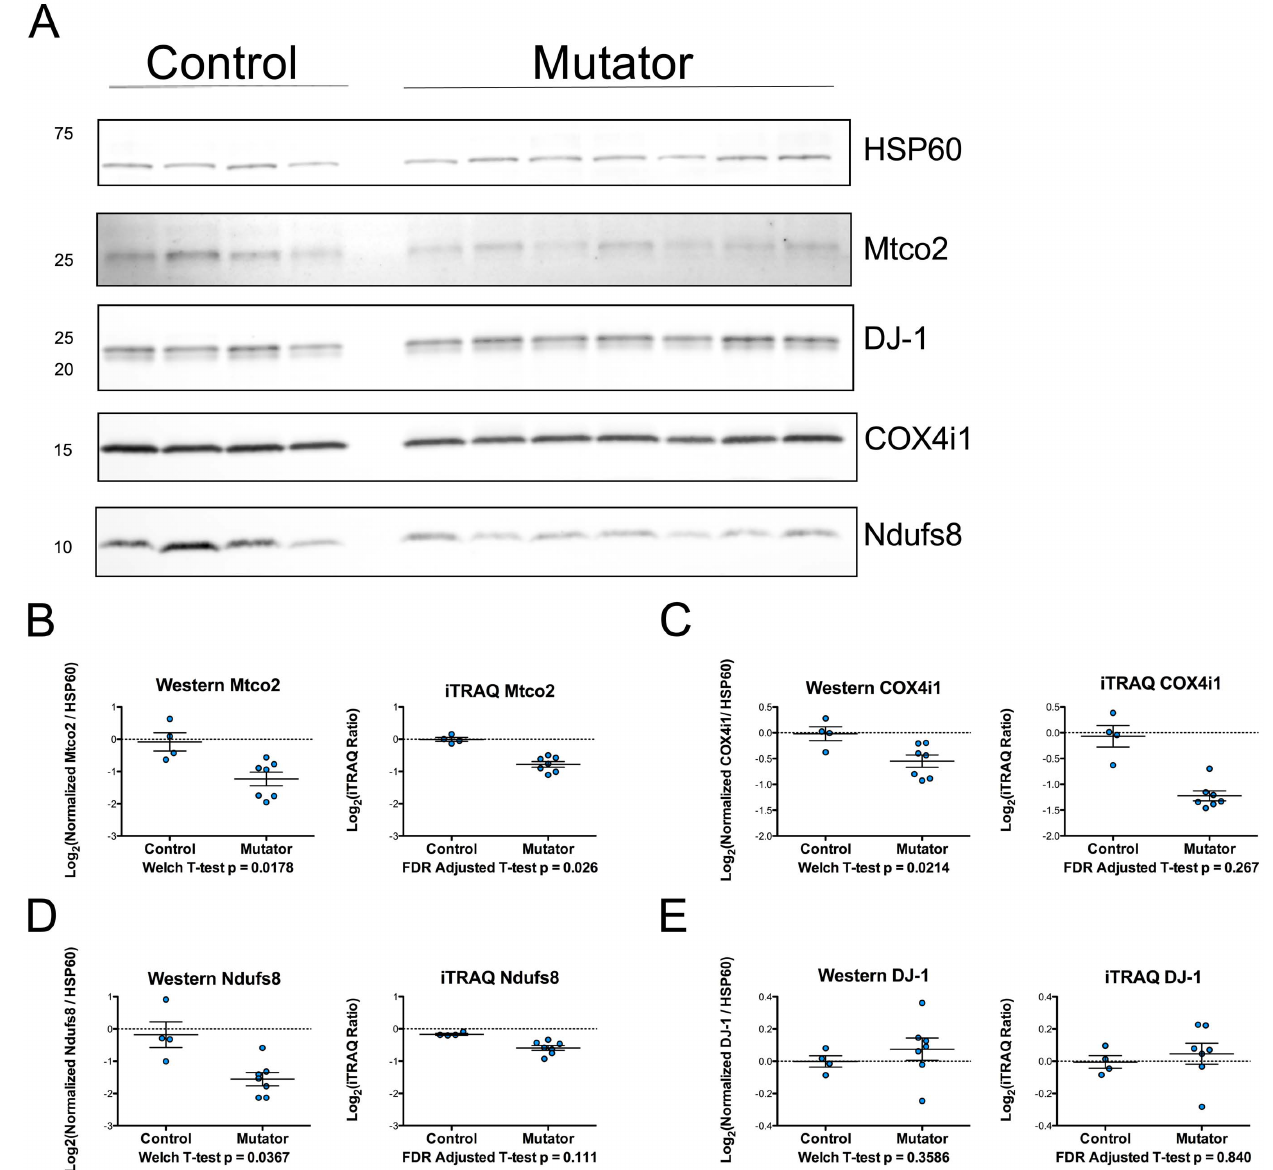
Figure 2. Validation of iTRAQ data using Western blots. A) Western blots for the loading control HSP60 and the proteins of interest Mtco2, DJ- 1, COX4i1, and Ndufs8. Proteins samples analyzed were from the 11 male mice used in the iTRAQ analysis. B–E) Quantitative data from Western blots and iTraq experiment for proteins of interest. Western blot data was normalized to the mean of the controls and log 2 transformed prior to comparison using Welch T-tests. HSP60 was used as a loading control to normalize the